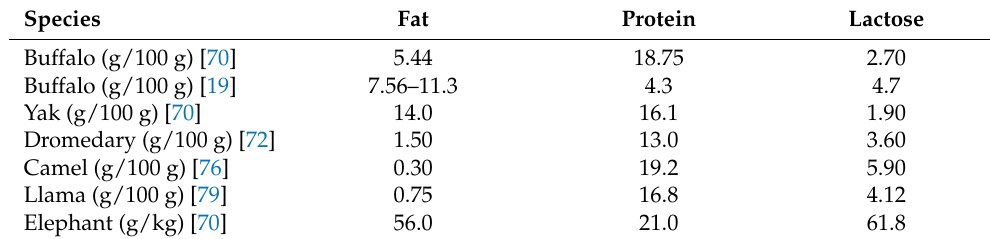
Table 4. Colostrum chemical composition in exotic ruminant species.